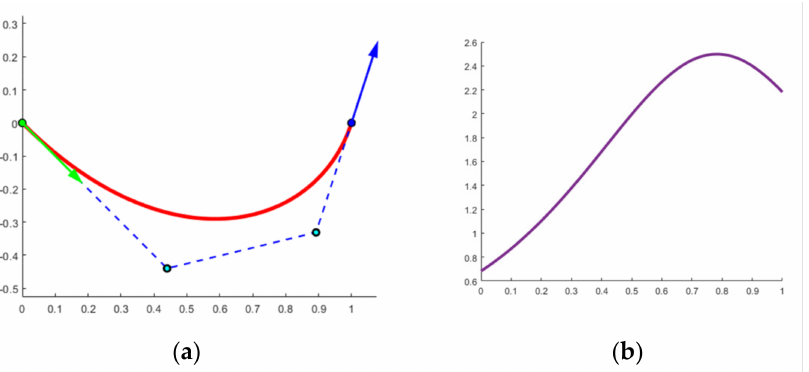
Figure 16. Cubic typical B é zier curve solution for − π /2 < α < 0 < β < π /2. ( a ) s r = 0.7482, = 0.6220; ( b ) corresponding curvature plot. (cid:107) ∆ b (cid:107) 0 r The second boundary constraints satisfy − π /2 < β < 0 < α < π /2 with α = π /3 and β = − π /3 (Figure 17). The point-tangent pairs are on a circular arc, and the interpolation curve will be symmetric with s r = 1.